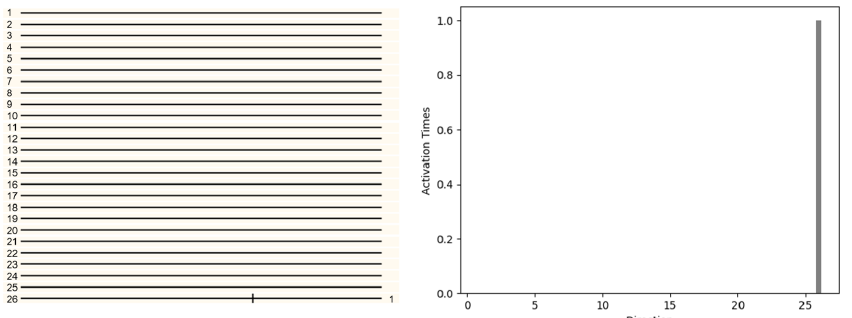
Figure 9. The neuron activation diagram in the twenty-six direction caused by the motion of the 1-voxel random-dot object in the three dimensional space ( left ). Each line represents 26 directions, each point on the line represents the detection neuron, and each stimulation on the line represents that the neuron at this point is activated. The number of activations represented by a histogram ( right ). The number of activations of neurons in all directions is displayed on the histogram. The 17th direction neurons have the highest number of activations. It can be referred that the object moves in the 17th